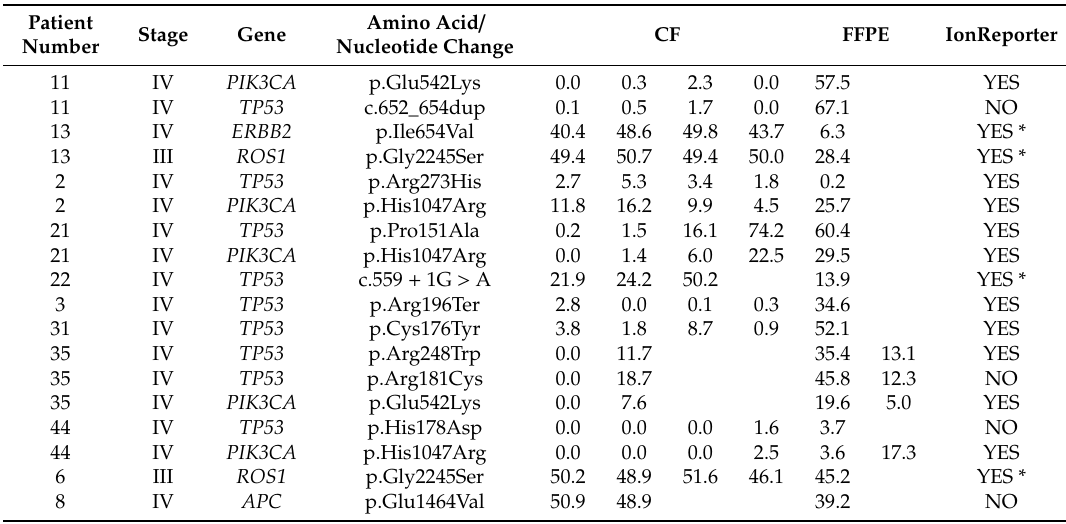
Table 4. Allele frequencies of pathogenic variants detected in FFPE also present in cfDNA samples based on Torrent Variant Caller